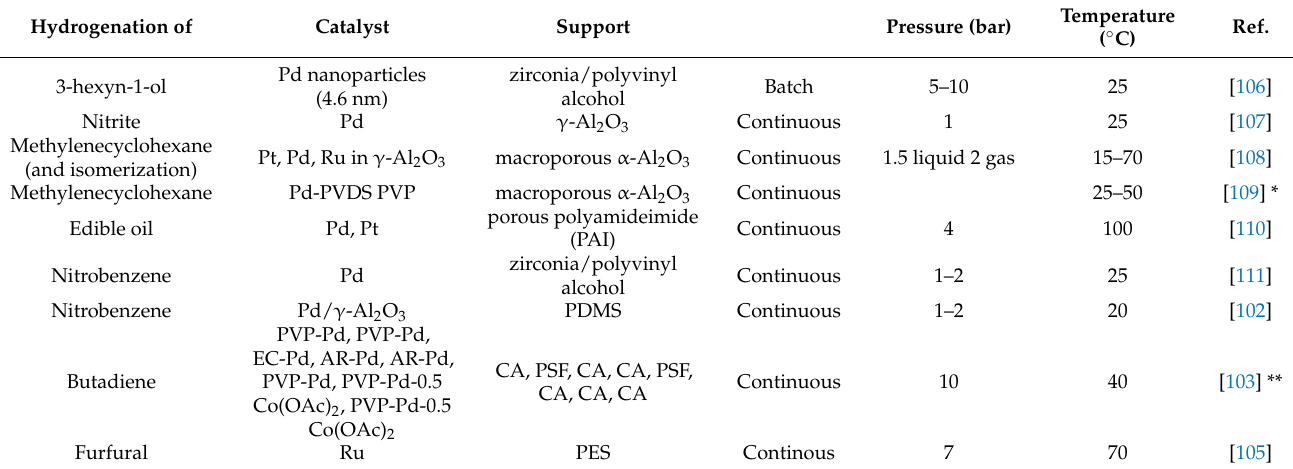
Figure 9. Kinetic rate of hydrogenation of levulonic acid using membrane reactors (MRs) and a packet bed reactor (PBR) [104]. Table 4. MR for hydrogenation reaction.